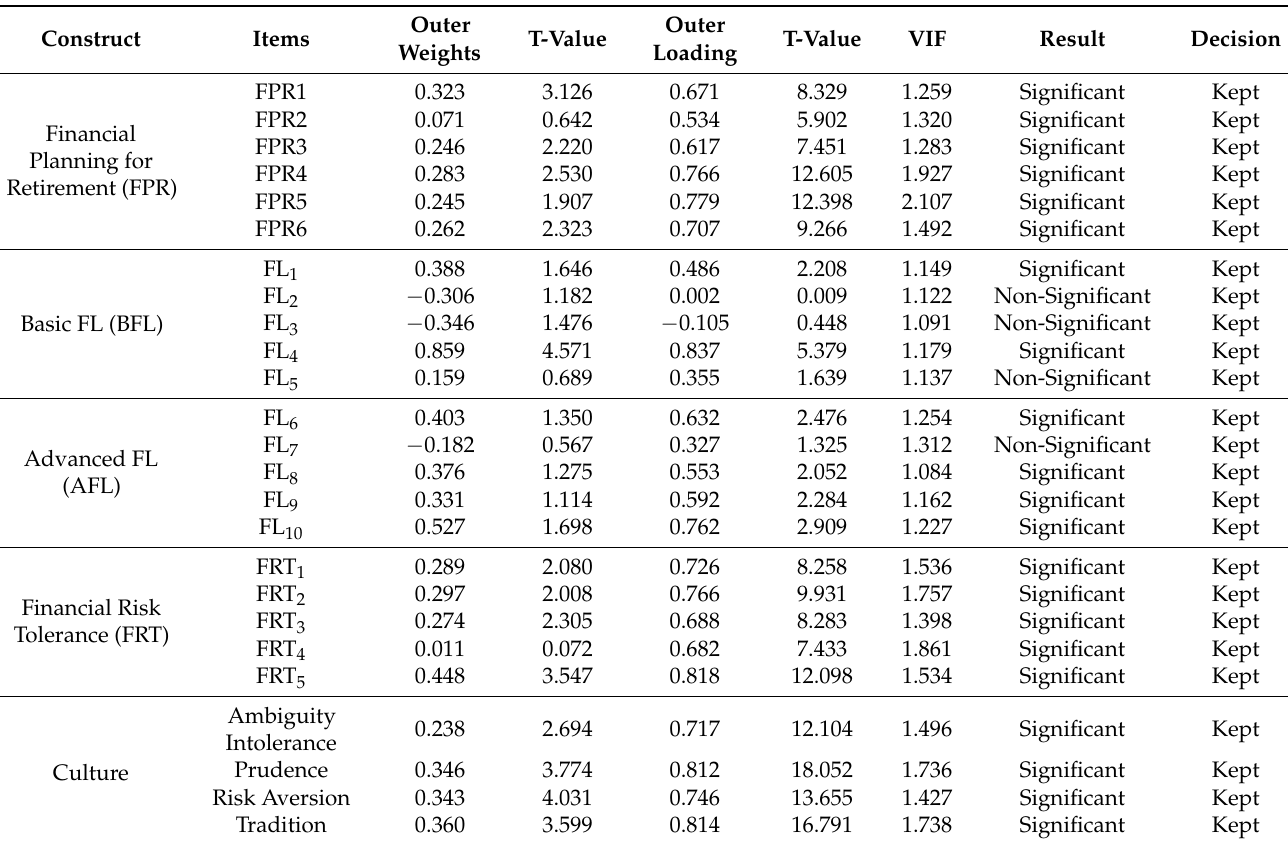
Table 5. Evaluation of Formative Measurement